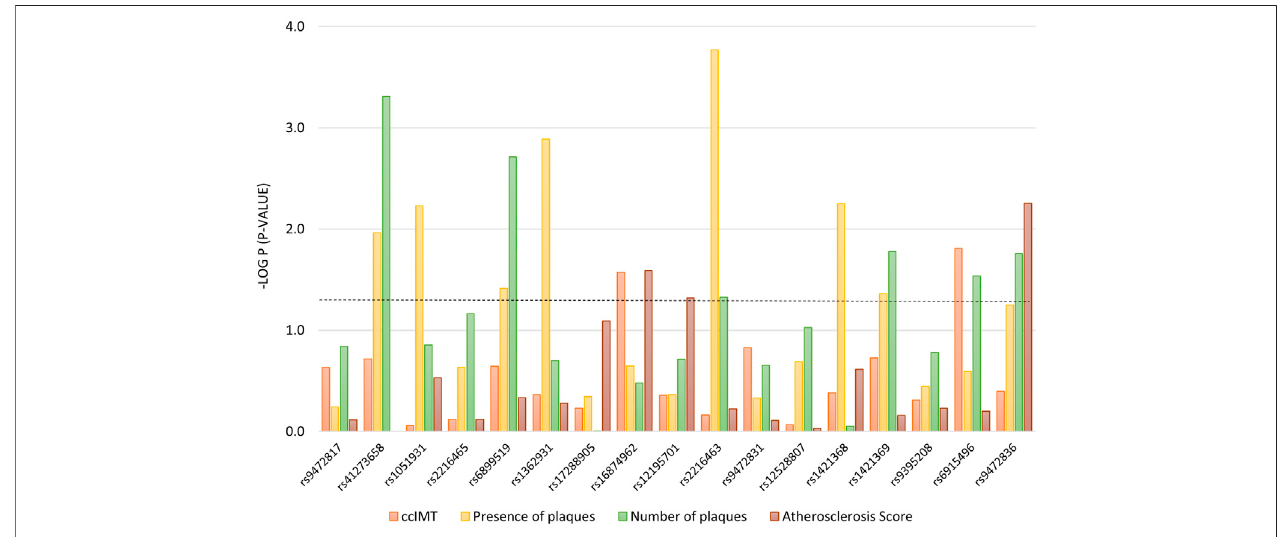
FIGURE 1 | Association between tag-SNPs in the PLA2G7 gene with atherosclerosis-related measurements. The dotted line denotes the level of statistical signi fi cance. ccIMT, common carotid intima media thickness (mm).